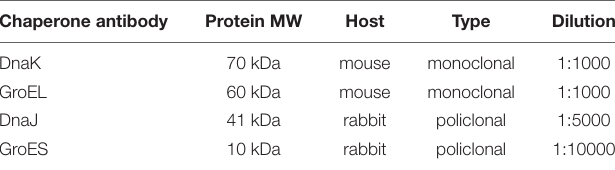
TABLE 2 | Antibodies for WB and the dilution